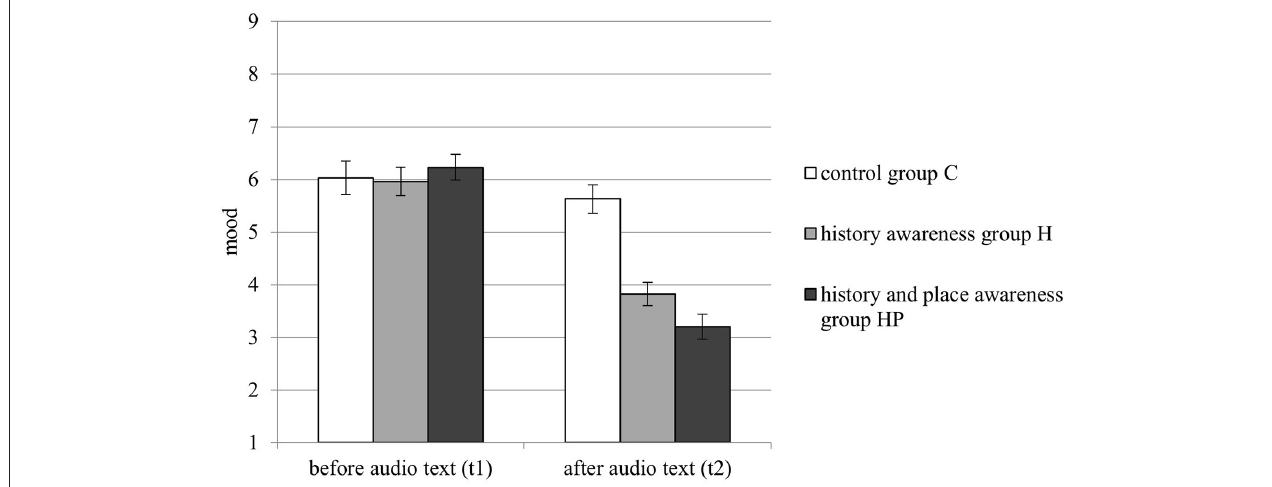
FIGURE 5 | Participants’ personal mood and arousal at three different times (t1, t2, t3) by condition. Lower scores indicate a more negative mood. Error bars represent standard error of mean. 1, no significant differences in valence ratings of the room were found between the groups C ( M = 3.90, SD = 0.84), H ( M = 3.75, SD = 1.32), and HP ( M = 3.47, SD = 1.43), F (2,85) = 0.968, p = 0.384, η p ² = 0.022. Also, while descriptively similar to Study 1, there were no differences in perceived arousal evoked by the room between the groups C ( M = 4.57, SD = 2.08), H ( M = 5.07, SD = 1.90), and HP ( M = 5.57, SD = 1.68), F (2,85) = 2.093, p = 0.130, η p ² =